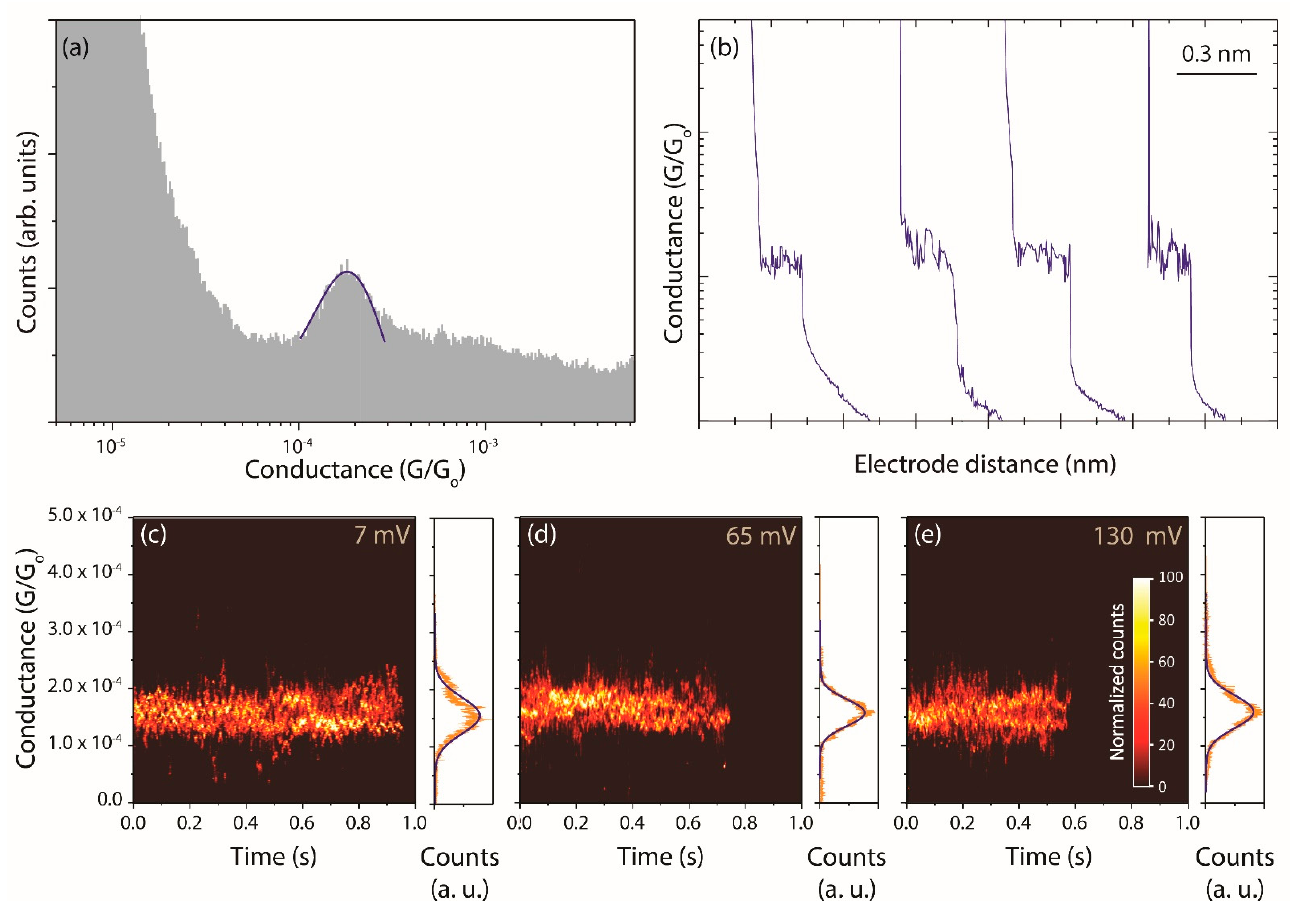
Figure A5. ( a ) Semi-logarithmic histogram from dynamic experiments for cis-TMC-syn control molecule displaying a single peak of LC fitted with a Gaussian. ( b ) Representative individual current versus gap distance traces. V bias = 20 mV. ( c – e ) 2D conductance maps of the cis-TMC-syn control molecule blinking experiments V bias = ( b ) 7 mV, ( c ) 65 mV and ( d ) 130 mV at a fixed gap distance. V bias was randomly changed for each set of experiments for a total time of 5h for each bias regime. Counts are normalized to a maximum of 100.